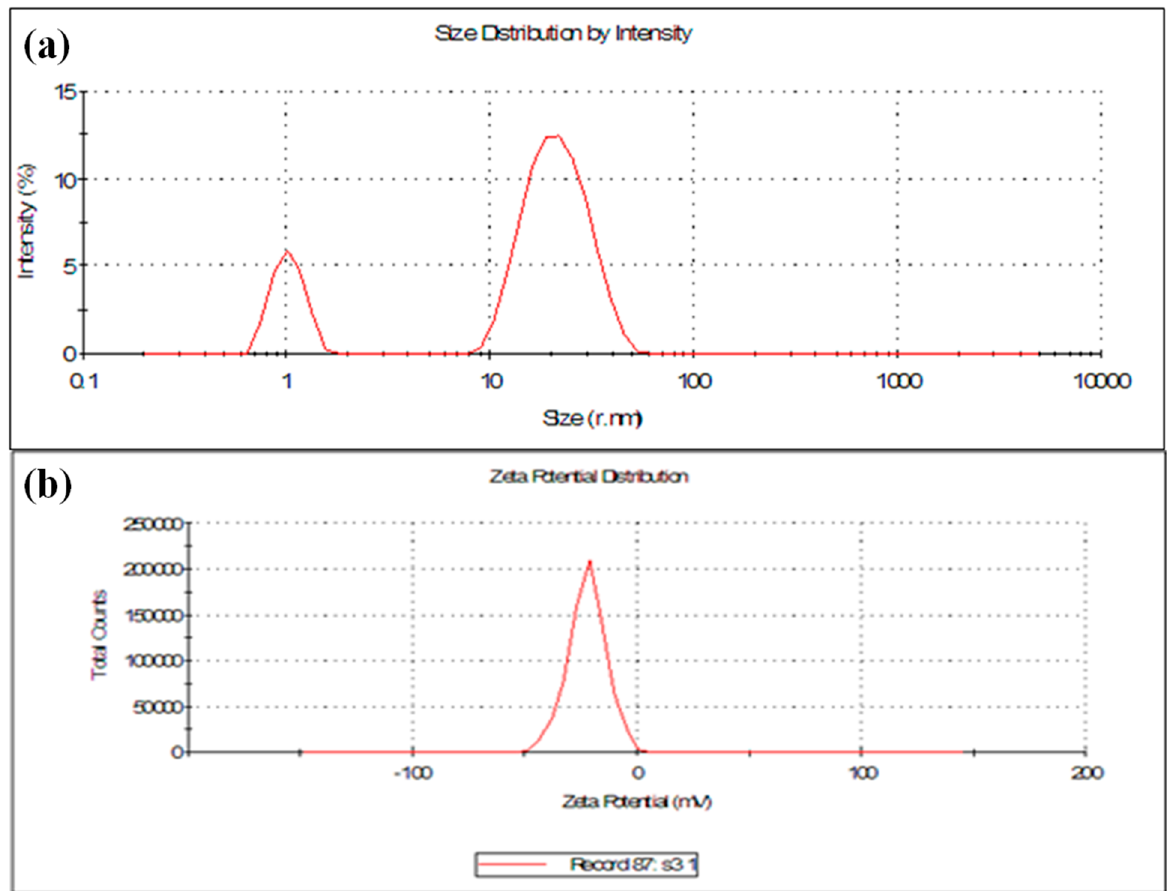
Figure 5. ( a ) Dynamic light scattering (DLS) and ( b ) zeta potential analysis of synthesized AgNPs.